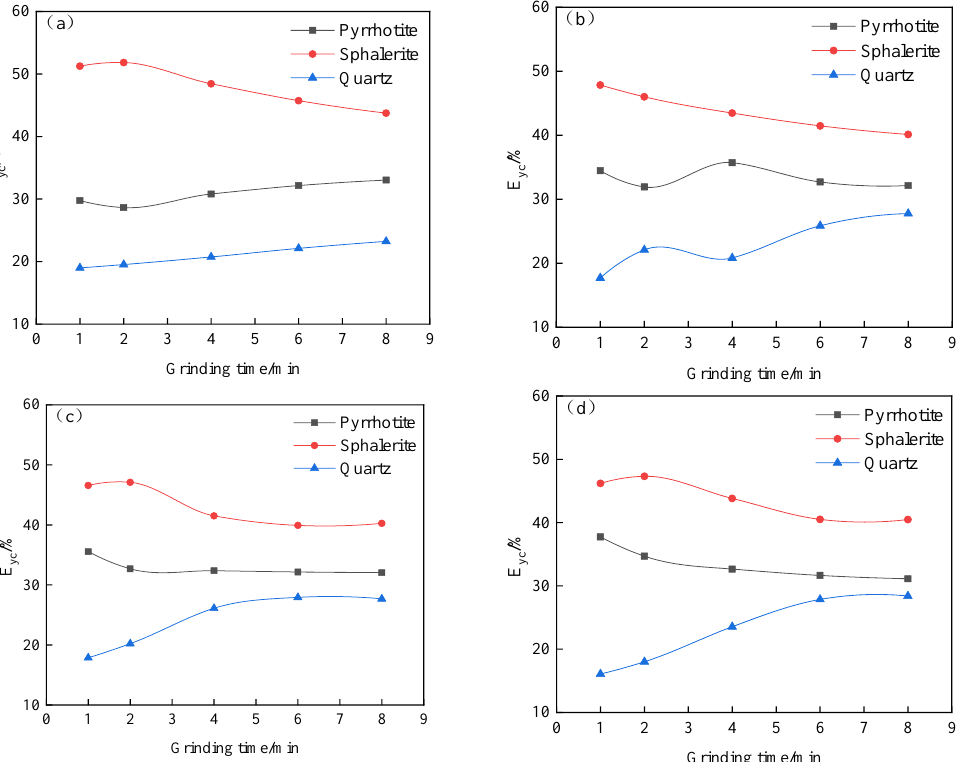
Figure 3. The contribution rate of component minerals for ore grinding characteristics at different feed sizes (( a ): −4.75 + 3.35 mm, ( b ): −3.35 + 2.36 mm, ( c ): −2.36 + 1.70 mm, ( d ): −1.70 + 1.18 mm). feed sizes (( a ): − 4.75 + 3.35 mm, ( b ): − 3.35 + 2.36 mm, ( c ): − 2.36 + 1.70 mm, ( d ): − 1.70 + 1.18